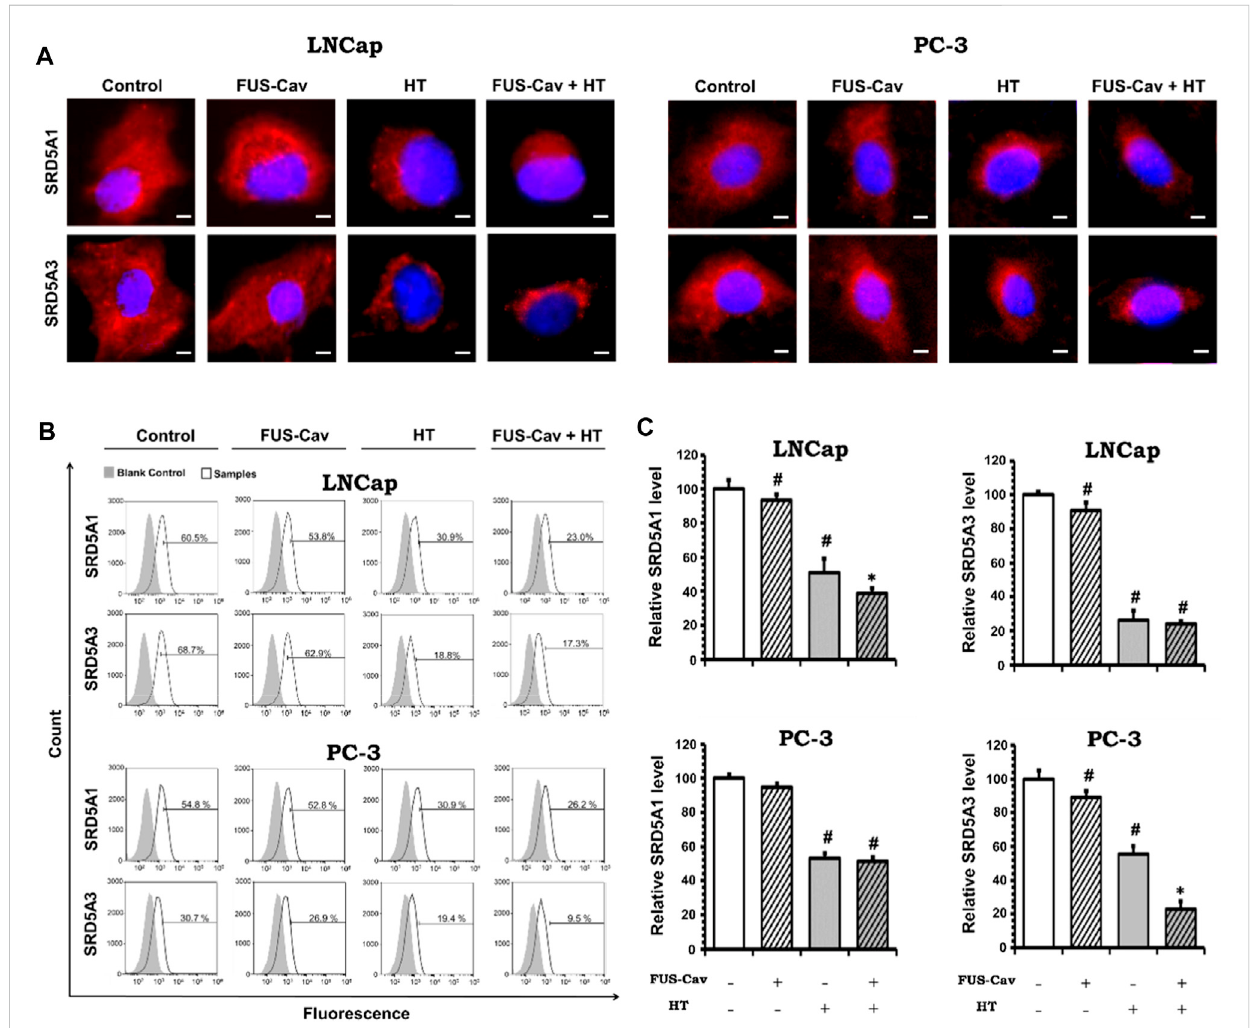
FIGURE 6 Effects of FUS-Cav to water bath HT decreasing the SRD5A distribution and expression were associated with cancer cell type. (A) Representative fl uorescence microscopy images for LNCap and PC-3 cells showing the distribution of SRD5A1 and SRD5A3 proteins in the cytoplasm 24 h post- treatment. Scale bar = 5 µm. (B) Flow cytometry results exhibit the percentage of immuno fl uorescence-positive cells in all collected LNCap and PC-3 cellsforanalysis:histogramsofimmuno fl uorescence-positivecellsshowingtheSRD5Alevel(percentageof fl uorescence-positivecellsindicatedin each plot) after each treatment. The fl uorescence-negative cells immune-stained in the absence of a primary antibody were set as the background control. (C) Statistical results of quantitative analysis with fl ow cytometry indicate SRD5A1 and SRD5A3 levels in LNCap and PC-3 cells 24 h post- treatment. Data were normalized to untreated control, which was set to 100%, and relative values are presented as mean ± SEM, n = 6, *signi fi cantly different from HT ( p ≤ 0.05), #signi fi cantly different from control ( p ≤